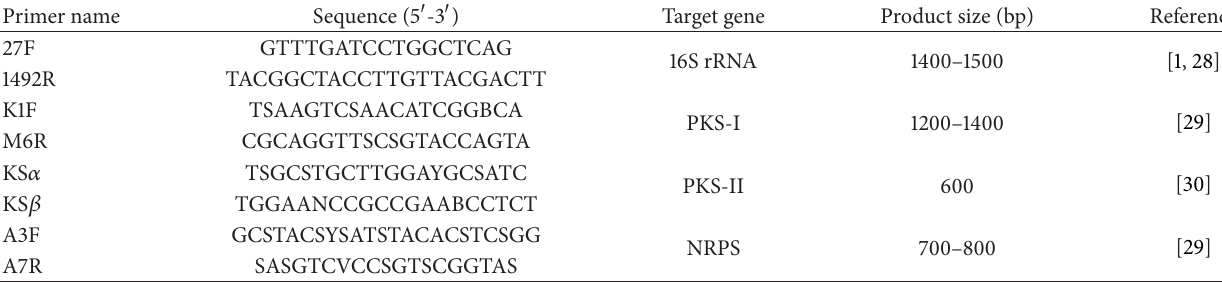
Table 1: PCR primers used in this